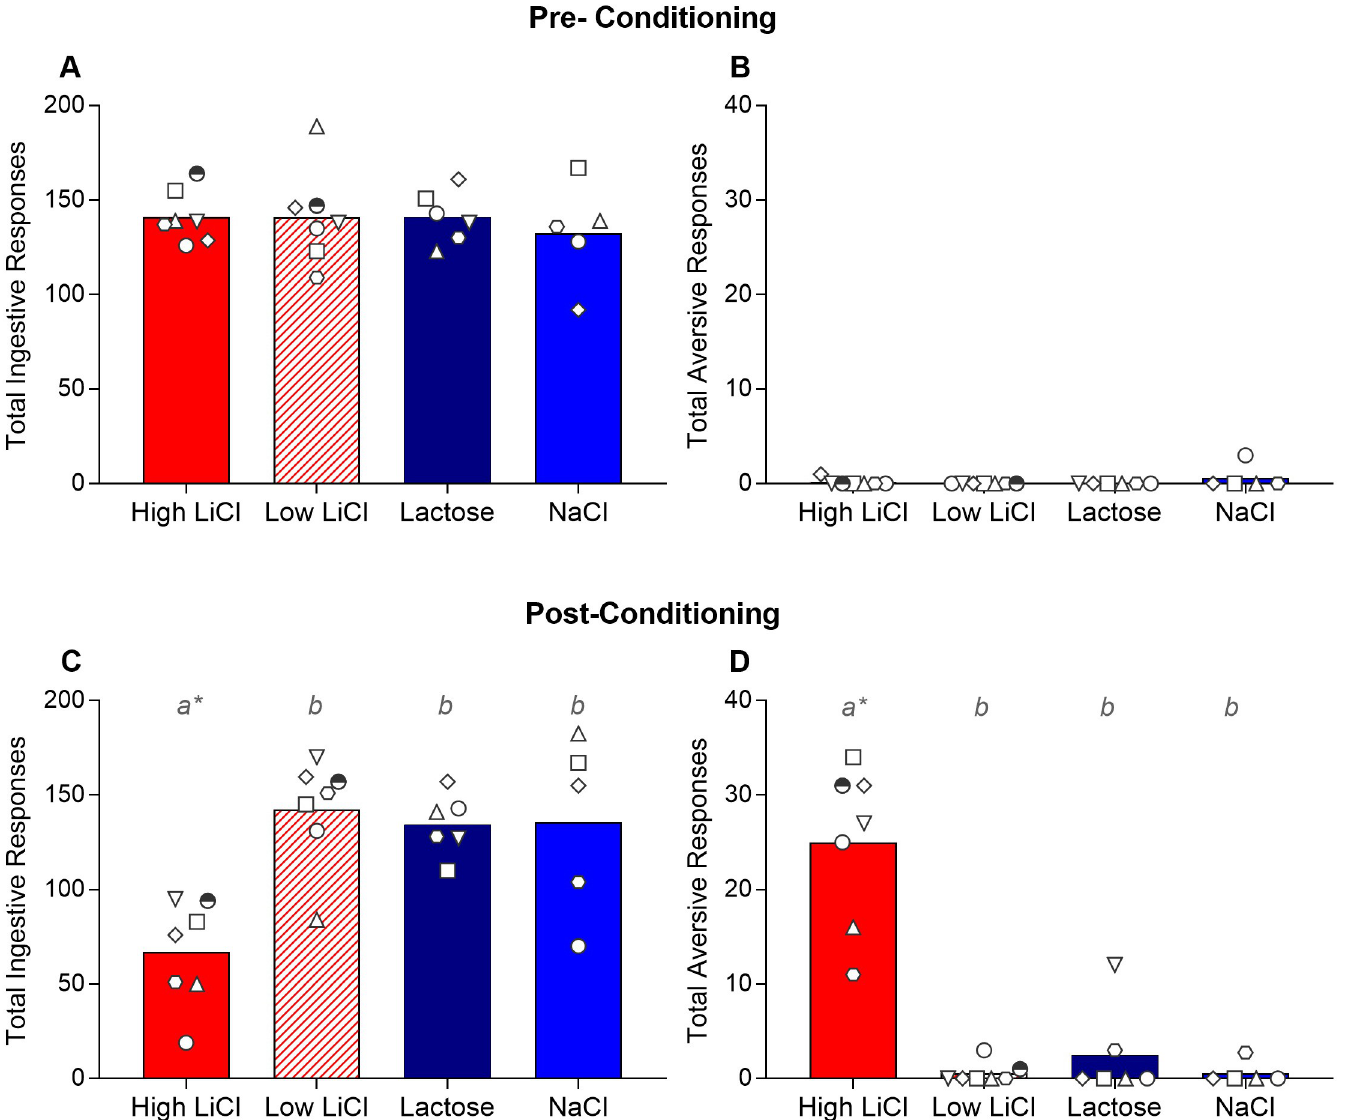
Fig 3. Top panel: Filled histograms show mean total ingestive (A) and aversive (B) taste reactivity responses elicited by a brief intraoral infusion of saccharin, the CS, prior to taste-ID conditioning, for each of the four training groups from Experiment 1a. Bottom panel: Filled histograms show mean total ingestive (C) and aversive (D) taste reactivity responses elicited by a brief intraoral infusion of saccharin, the CS, after taste-ID conditioning for each training group from Experiment 1a. The responses of each individual rat within each training group are plotted in the white symbols. The symbol for a given rat within each group corresponds across graphs in this figure and other Experiment 1a figures. Histograms with different gray letters were found to be significantly different from one another with post hoc t-tests, Bonferroni- corrected for multiple comparisons. The asterisk indicates post-training score was significantly different from pre-training score, after Bonferroni correction.